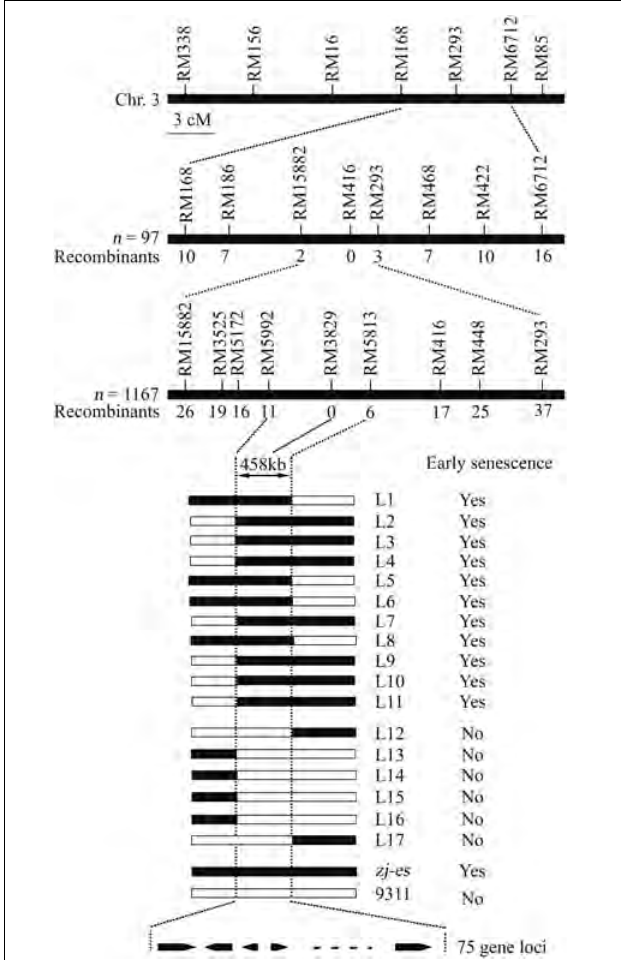
FIGURE 2 | Molecular mapping of the ZJ-ES gene on Chromosome 3. ZJ-ES locus was initially mapped in a region between markers RM15882 and RM293 on Chromosome 3 and was further narrowed to about 458 kb region between markers RM5992 and RM5813 with 75 predicted gene loci. The numbers of individuals in F2 population and the recombinants of each marker are